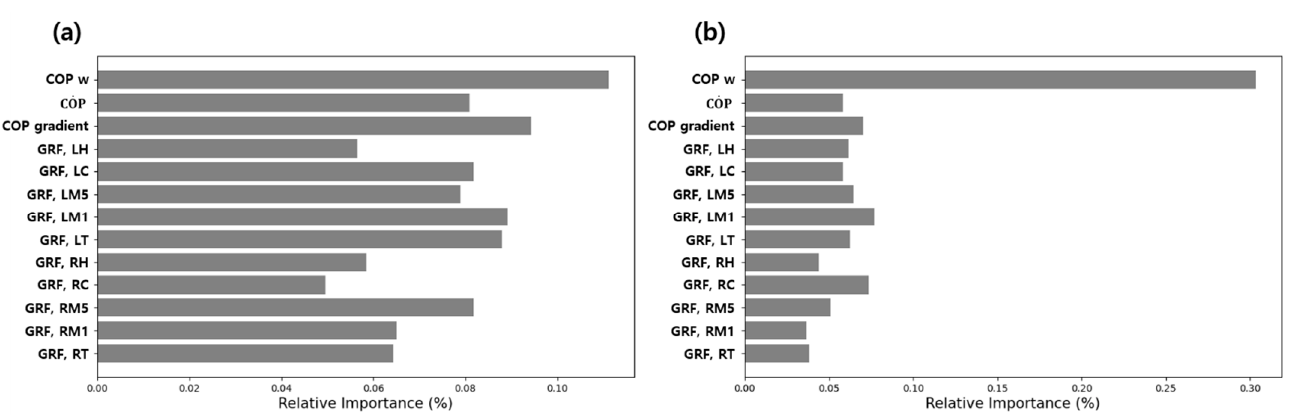
Figure 10. Relative importance of the factors: ( a ) healthy adult group ( b ) patient group